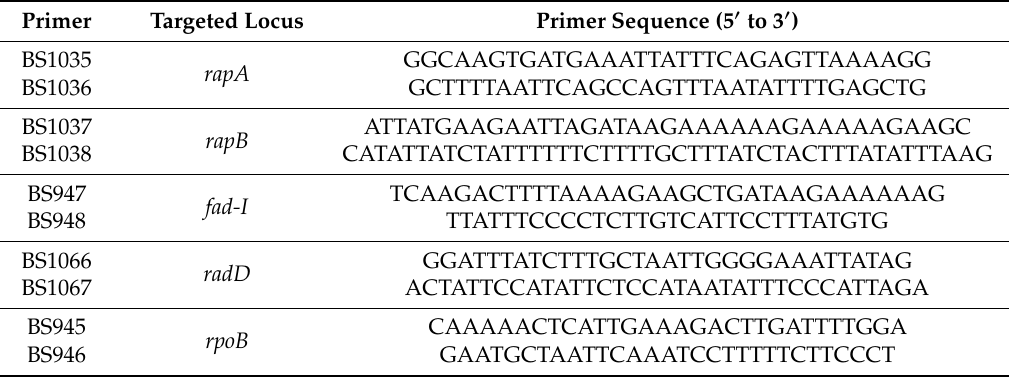
Table 2. List of qPCR primers used in the